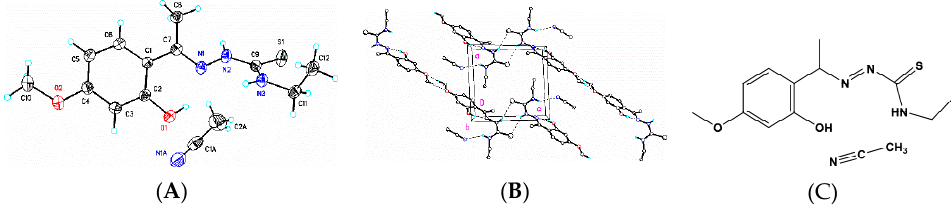
Figure 3. ( A ) ORTEP drawing of ( 3 ) showing the atom numbering scheme and 50% probability displacement ellipsoids of non-H atoms; ( B, C ) The molecular packing of ( 3 ) viewed along the b axis. Dashed lines indicate O–H … N intramolecular hydrogen bonds and weak N–H … S, N–H … N, C–H … O intermolecular interactions. Hydrogen atoms not involved in hydrogen bonding have been removed for clarity.